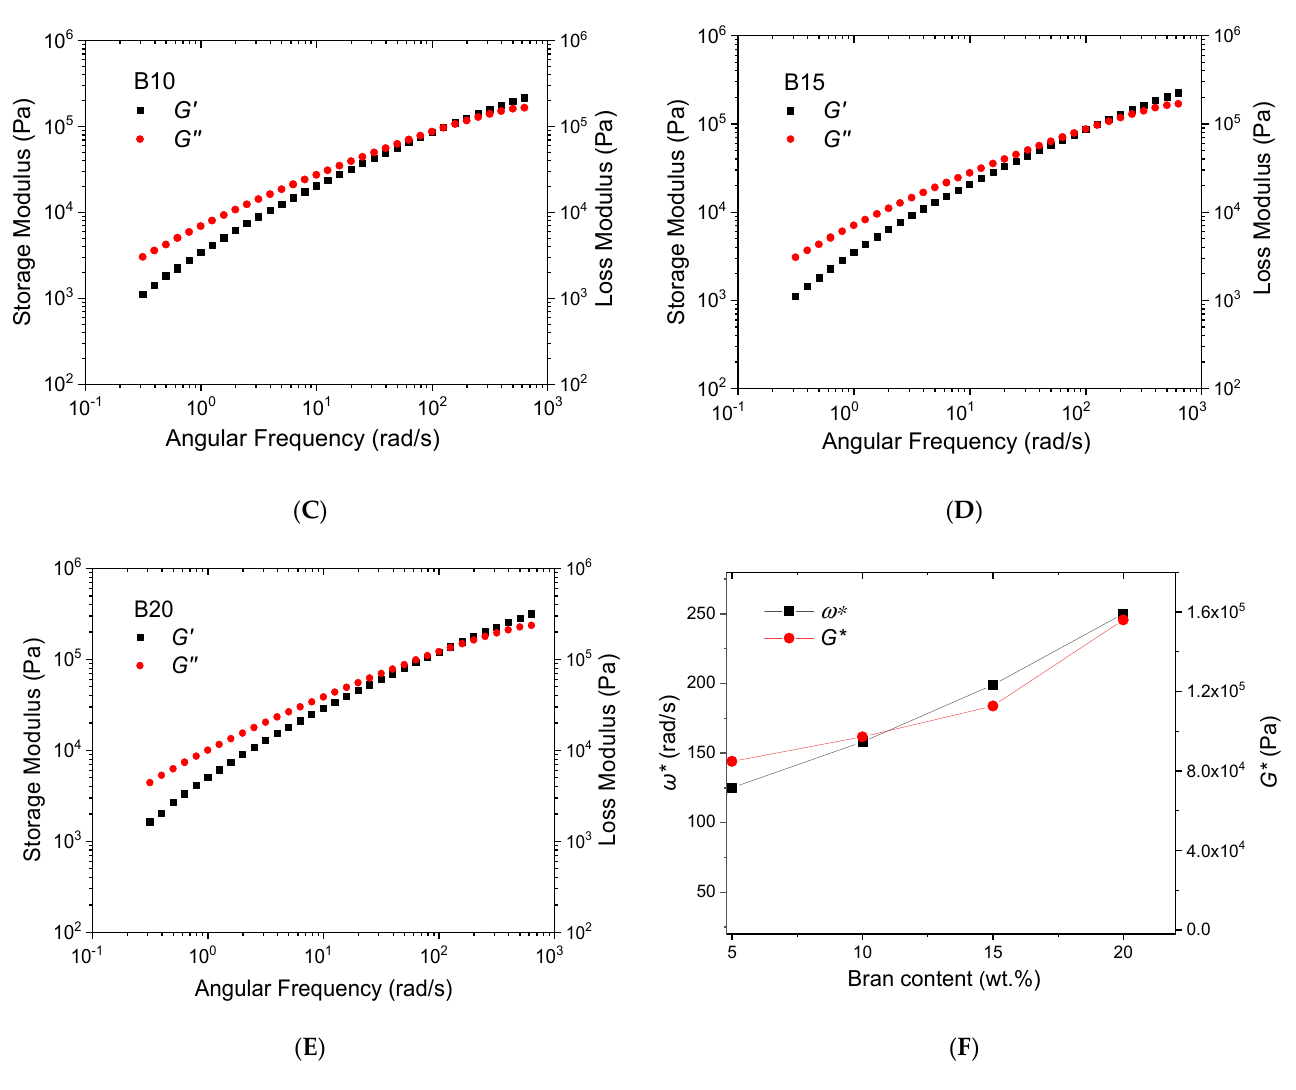
the fi ller and polymer matrix were observed. In conclusion, the addition of bran only re- Figure 7. ( A – E ) Storage ( G ′ ) and loss ( G ″ ) modulus versus angular frequency of the PBSA and duced the intensity of signi fi cant PBSA peaks, indicating that bran acts as an inert fi ller Figure 7. ( A – E ) Storage ( G (cid:48) ) and loss ( G (cid:48)(cid:48) ) modulus versus angular frequency of the PBSA and PBSA/B composites at 145 °C; ( F ) G cross and ω cross of the composites vs. bran content. [59]. PBSA/B composites at 145 ◦ C; ( F ) G cross and ω cross of the composites vs. bran content.